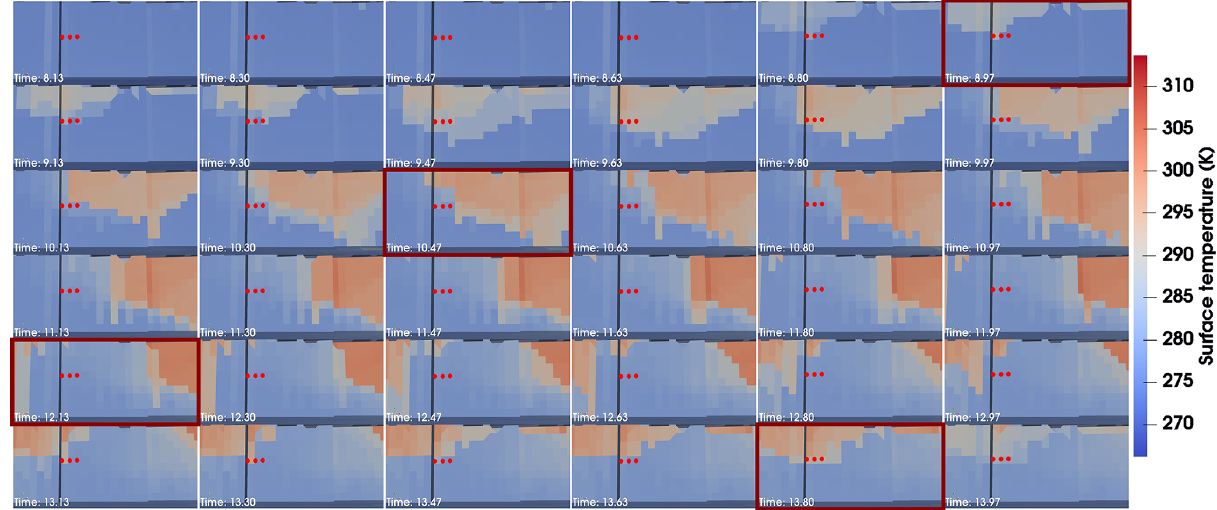
Figure 19. Timeline of 10min model outputs of wall surface temperature on 5 December 2018 from 05:28 to 12:48UTC. The time steps from the previous figure (Fig. 18) are highlighted using a red frame, and the positions of the evaluation points 1, 2, and 3 are marked by red dots. For technical reasons, the step times for the model views express minutes as decimal fractions of the hours.